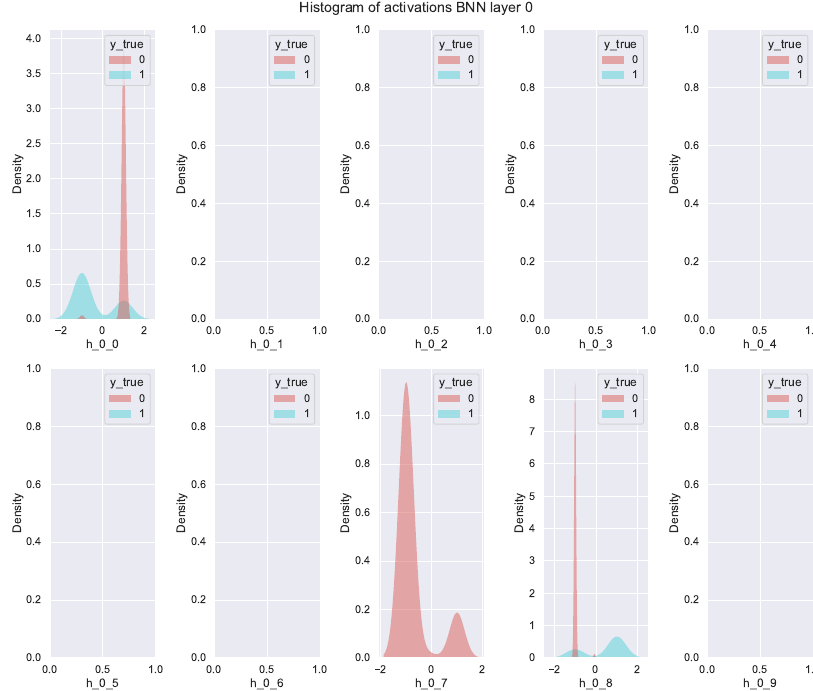
Figure 9. Histogram of binary activations generated employing KDE for neurons in hidden layer zero in DL predictor for BCWD dataset. Each plot shows the activation density function per neuron discriminated by class (class 0 is shown in red, and class 1 is shown in blue). Empty plots correspond to neurons that have zero variance and present the same activation value for all the samples, thus are not